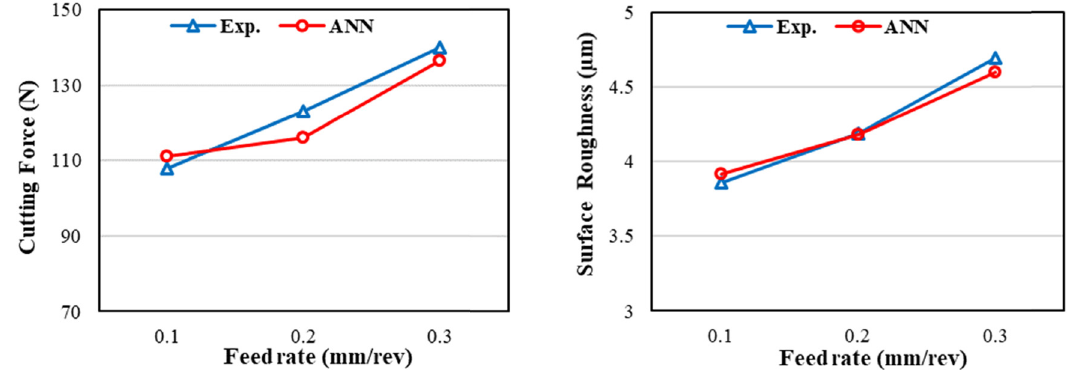
Figure 13: Comparison of experimental data and ANN for depth of cut 2 mm, cutting speed 100 m · min − 1 , and orientation angle